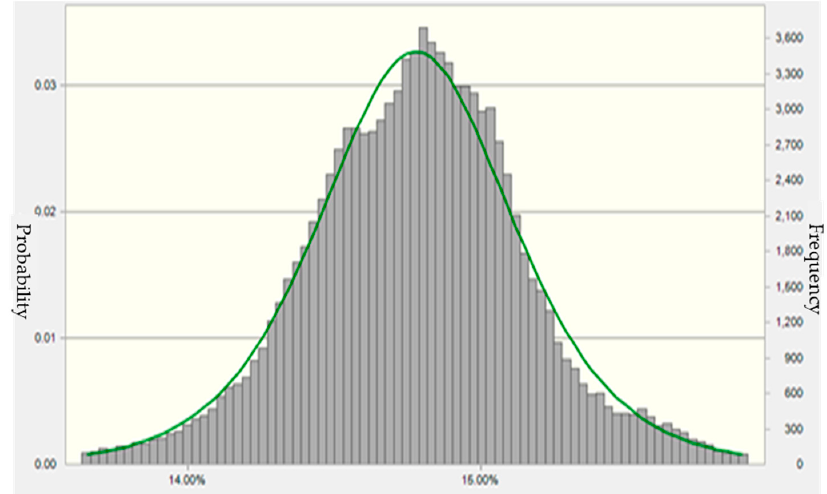
Figure 2. Probability distribution for capacity factor (logistic distribution).